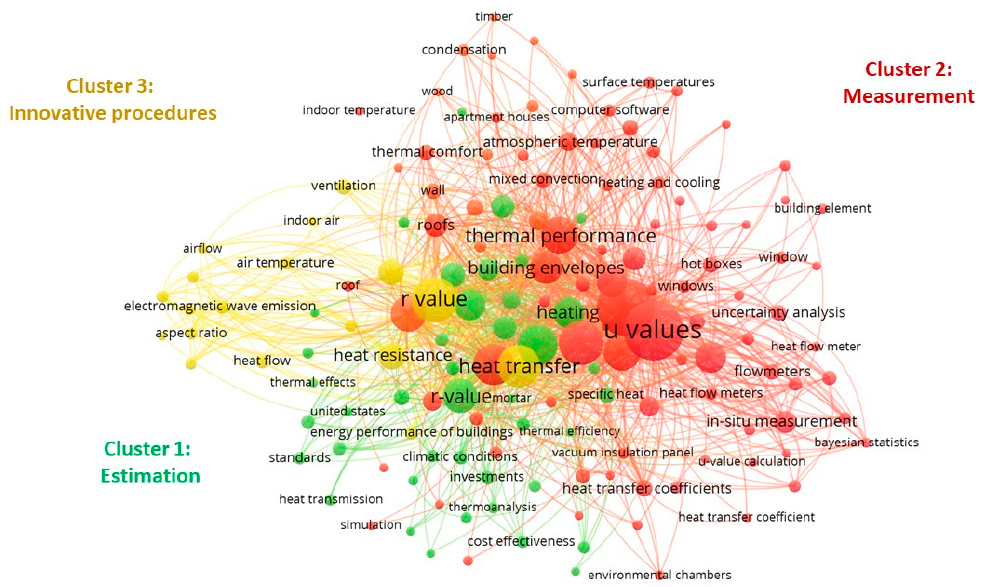
Figure 5. Co-occurrence network of keywords on the topic “ thermal transmittance assessment of building *” (source: authors’ elaboration using VOSviewer, based on Scopus data).